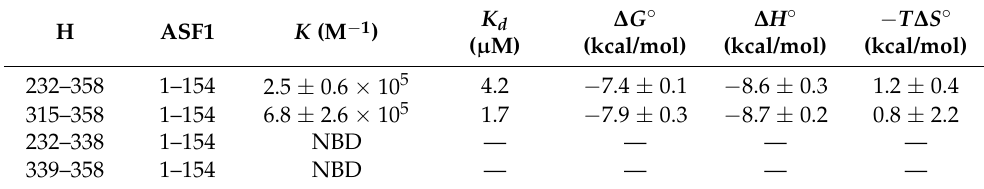
Table 1. ITC binding for complexes formed between H and ASF1.